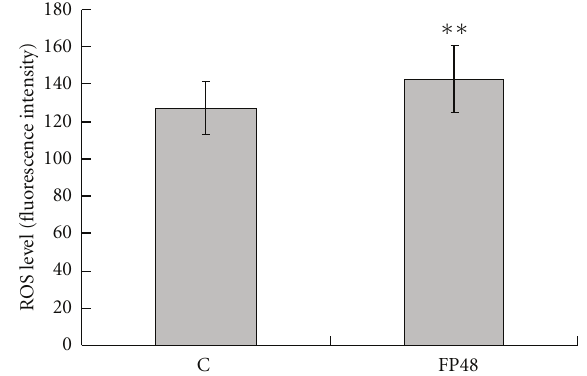
Figure 7: Intracellular ROS by flow cytometry. Expression values of the control (group C) and cFIR (group FP48) groups are the mean and standard deviation, and the statistical di ff erence was detected by the Wilcoxon